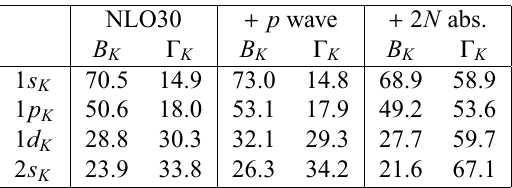
Table 1. Self-consistently calculated binding energies B K and widths Γ K (in MeV) of K − quasibound states in Ca, using a static RMF Ca density and NLO30 in-medium K − N subthreshold amplitudes, see text. NLO30 + p wave + 2 N